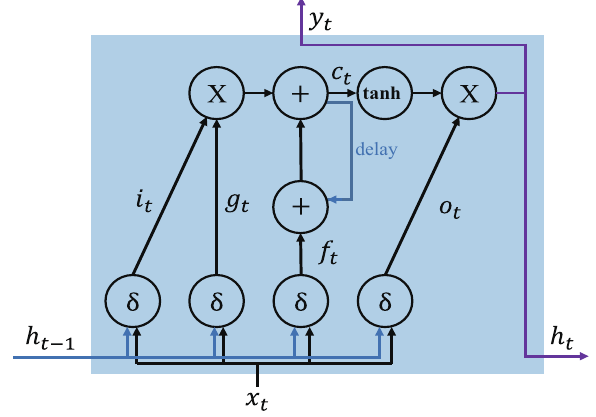
Figure 3. Schematic of an LSTM memory cell structure with an inner recurrence c t and an outer recurrence h t . i t , o t , f t , and g t